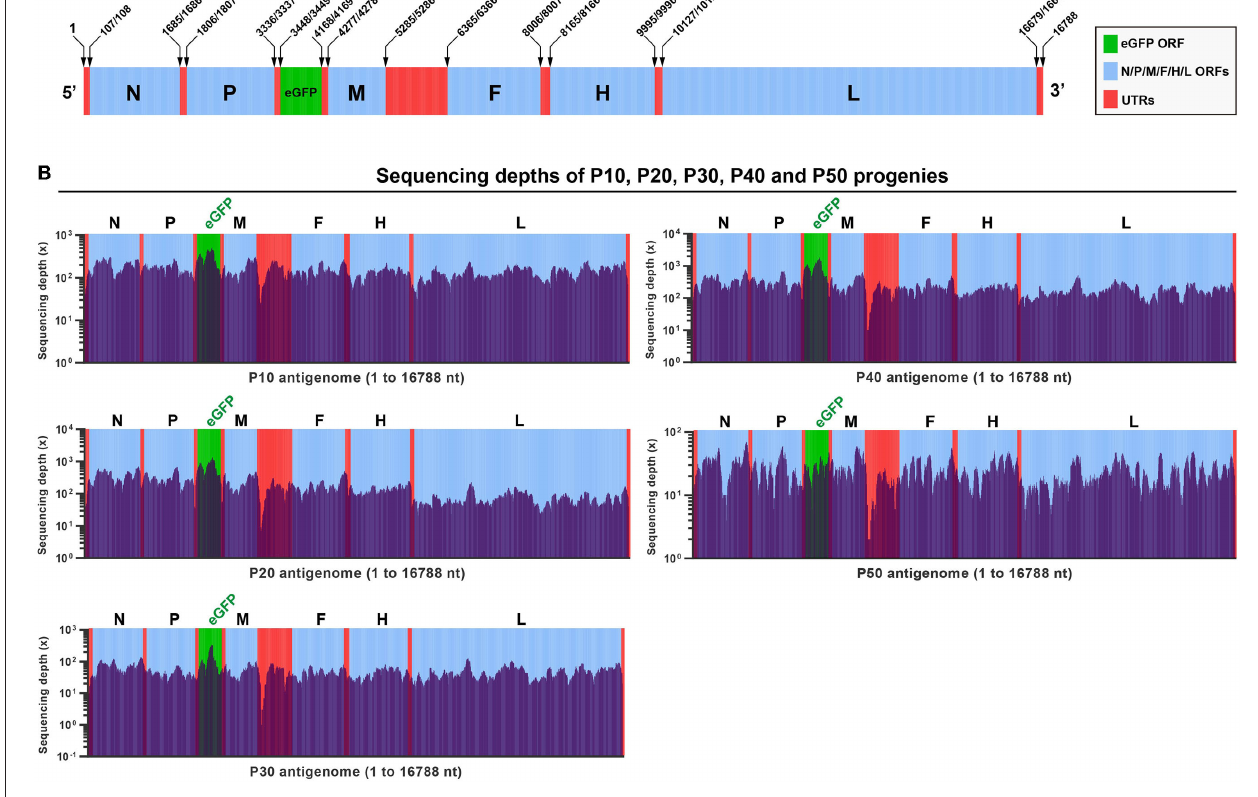
FIGURE 2 | Analyses on next-generation sequencing of rSRMV-eGFP progenies. Schematic representation of rSRMV-eGFP antigenome (A) . All elements proportionally match their actual lengths in viral antigenome. ORF: open reading frame; UTR: untranslated region. Depth and coverage of next-generation sequencing across the rSRMV-eGFP antigenome at P10, P20, P30, P40, and P50 (B) . All elements proportionally match their actual lengths in viral